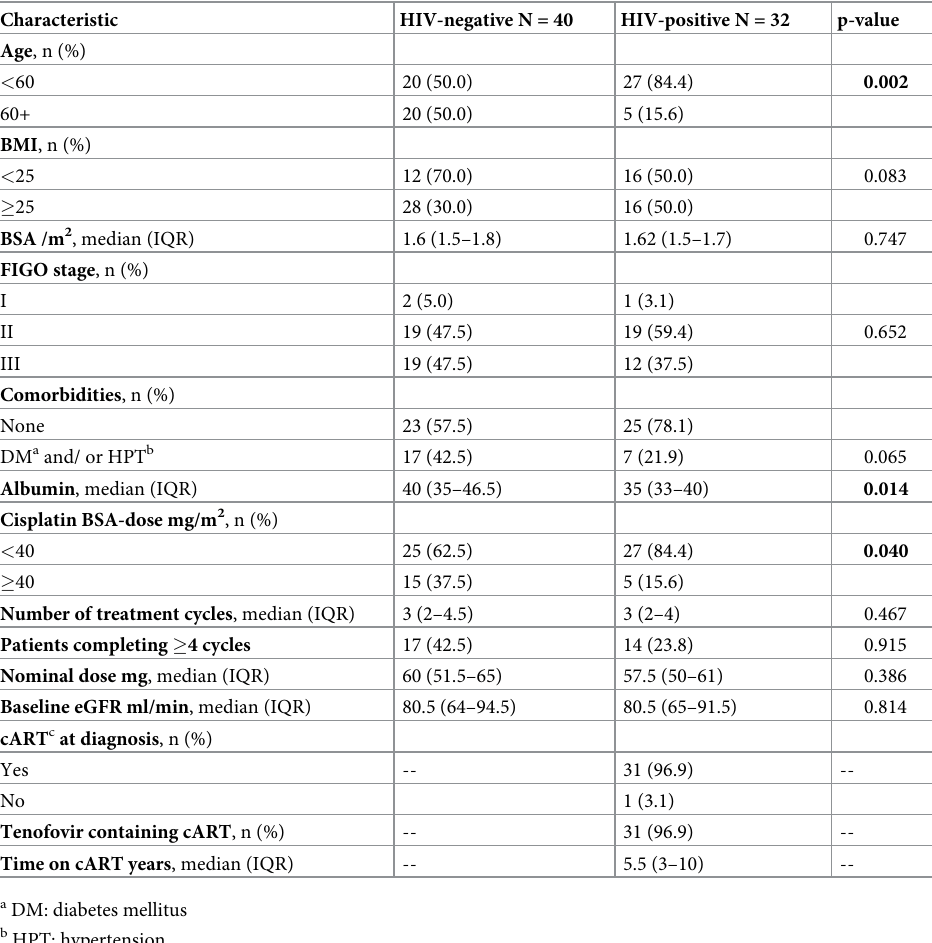
Table 1. Female patient